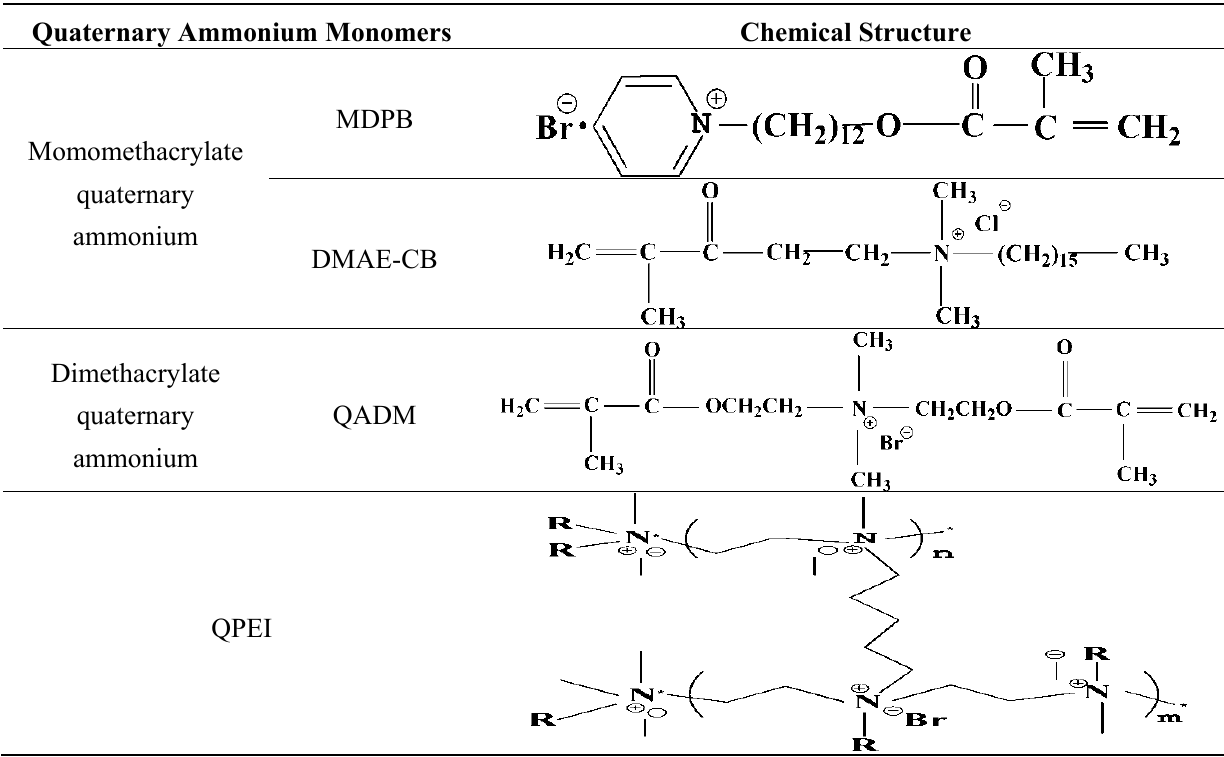
Figure 1. Schematic illustration of the antibacterial mechanism of quaternary ammonium monomers. Table 1. Chemical structures of different quaternary ammonium